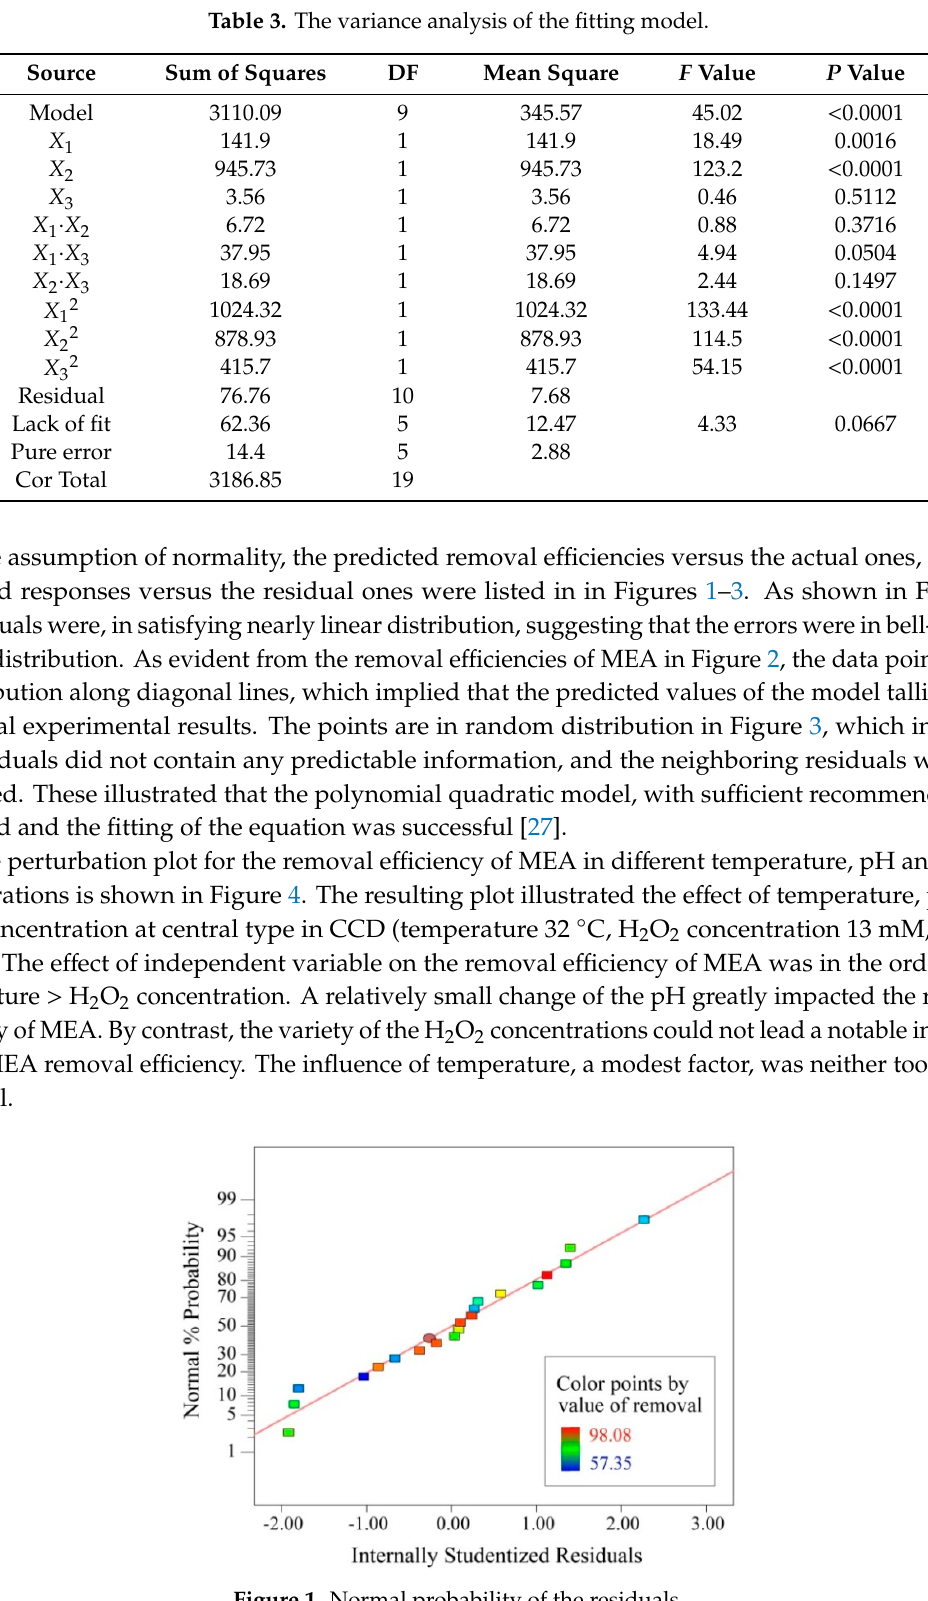
Table 3. The variance analysis of the fitting model.